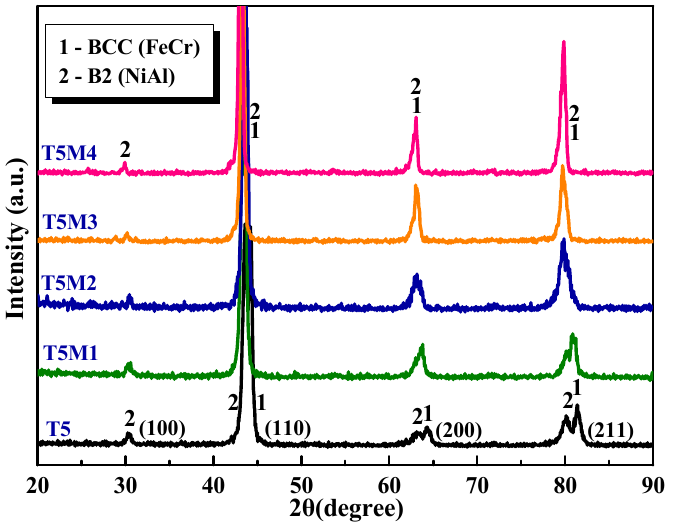
Figure 1. X-ray diffraction patterns of AlCrFeNiTi 0.5 , AlCrFeNiTi 0.5 Mo 0.1 , AlCrFeNiTi 0.5 Mo 0.2 , AlCrFeNiTi 0.5 Mo 0.3 , and AlCrFeNiTi 0.5 Mo 0.4 HEAs.